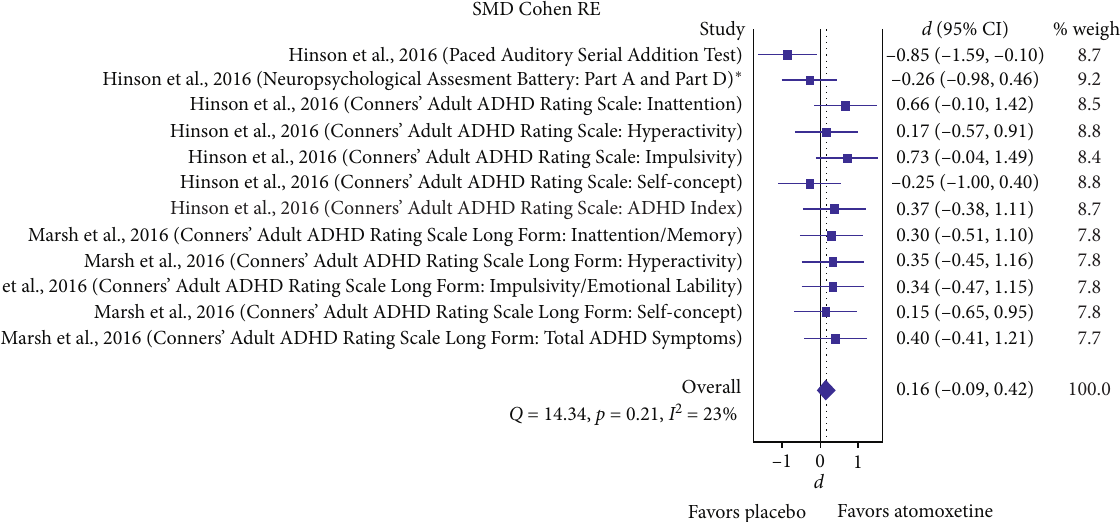
Figure 2: Forest plots showing the change in complex attention (DSM-5) (for Marsh et al. 2009 study, preatomoxetine data were compared to postatomoxetine data; for Hinson et al. 2016, postatomoxetine data were compared to placebo data) (ADHD: attention-deficit hy- peractivity disorder). ∗ The scores of Neuropsychological Assessment Battery (Part A and Part D) were